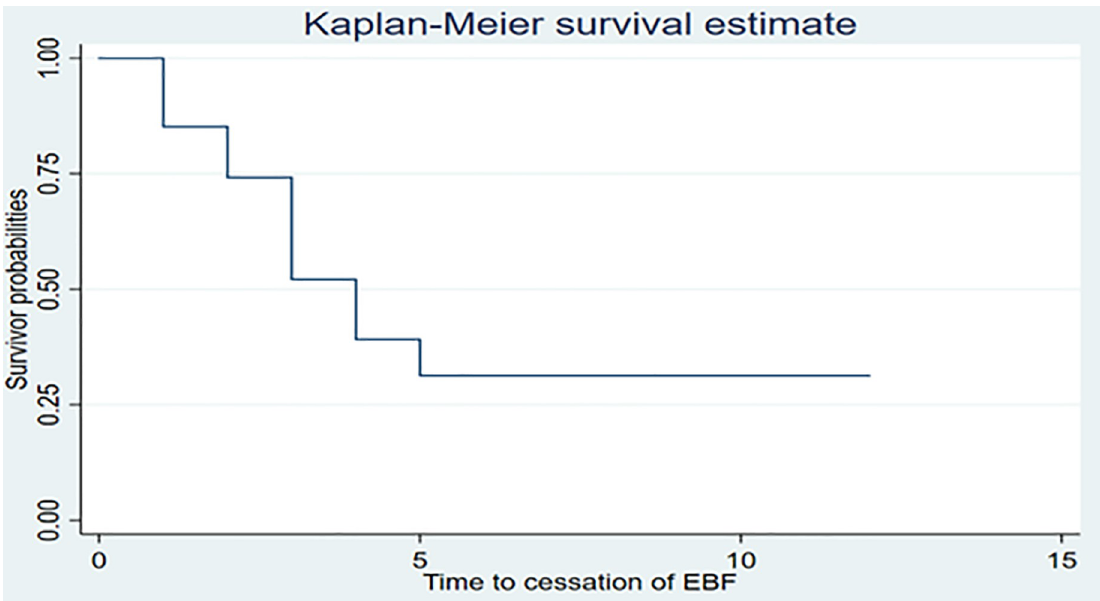
Fig 2. Survival function for time to cessation of exclusive breastfeeding (N = 1291).